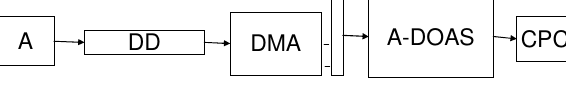
Figure 4. A flow diagram of experimental setup used to measure the optical properties of a 2 Fig. 4. A flow diagram of experimental setup used to measure monodisperse PSL sample with the AE-DOAS. A = atomizer, DD = diffusion dryer, DMA = 3 the optical properties of a monodisperse PSL sample with the AE- DOAS. A=atomizer, DD=diffusion dryer, DMA=differential mo- differential mobility analyzer, AE-DOAS = aerosol extinction differential optical absorption 4 bility analyzer, AE-DOAS=aerosol extinction differential optical spectrometer, which is shown in detail in Fig. 2, and CPC = condensation particle counter. 5 absorption spectrometer, which is shown in detail in Fig. 2, and CPC=condensation particle counter. Additional instrument details Additional instrument details are given in the experimental section. 6 are given in the experimental section.